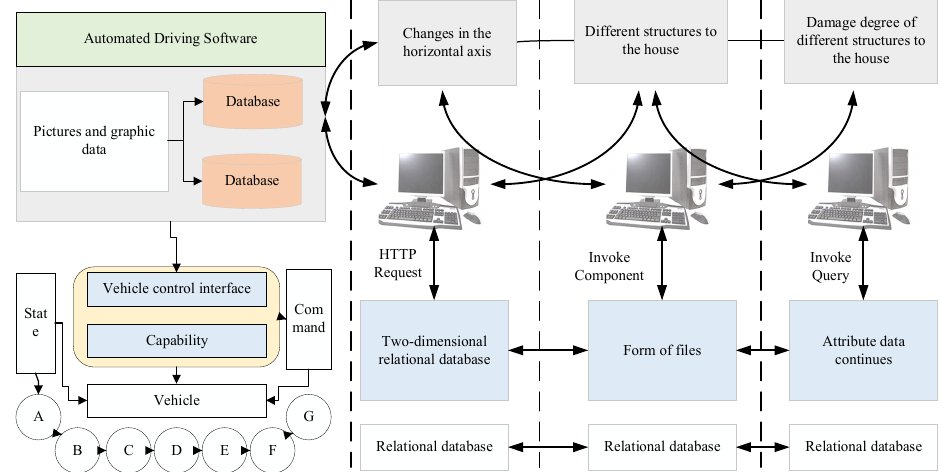
Figure 1. Tourism information data visualization technology.